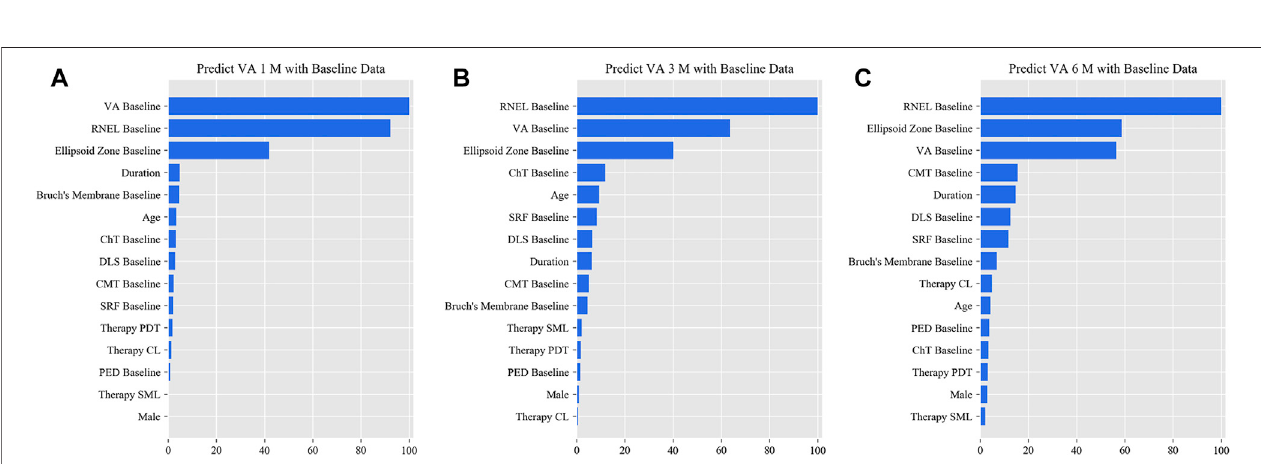
FIGURE 5 | Relative importance of different features of prediction for simpli fi ed model Ⅰ . These plots show the weights of the different features in the VA prediction task 1, 3, and 6 months after laser treatment for model Ⅰ . The results were strati fi ed according to the follow-up period and the points input into the algorithms; this fi gure shows only the relative importance of the baseline data. The red bar indicates the average importance of the feature in the blending algorithm. (A) Feature weights in the 1-month VA prediction. (B) Feature weights in the 3-month VA prediction. (C) Feature weights in the 6-month VA prediction.